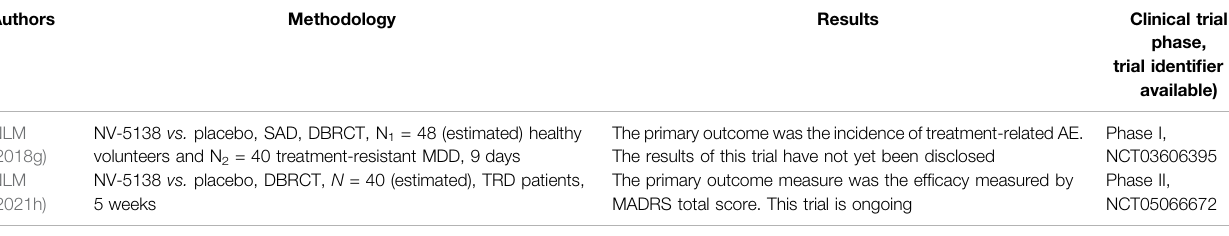
TABLE 2 | Sestrin modulators with antidepressant properties in the